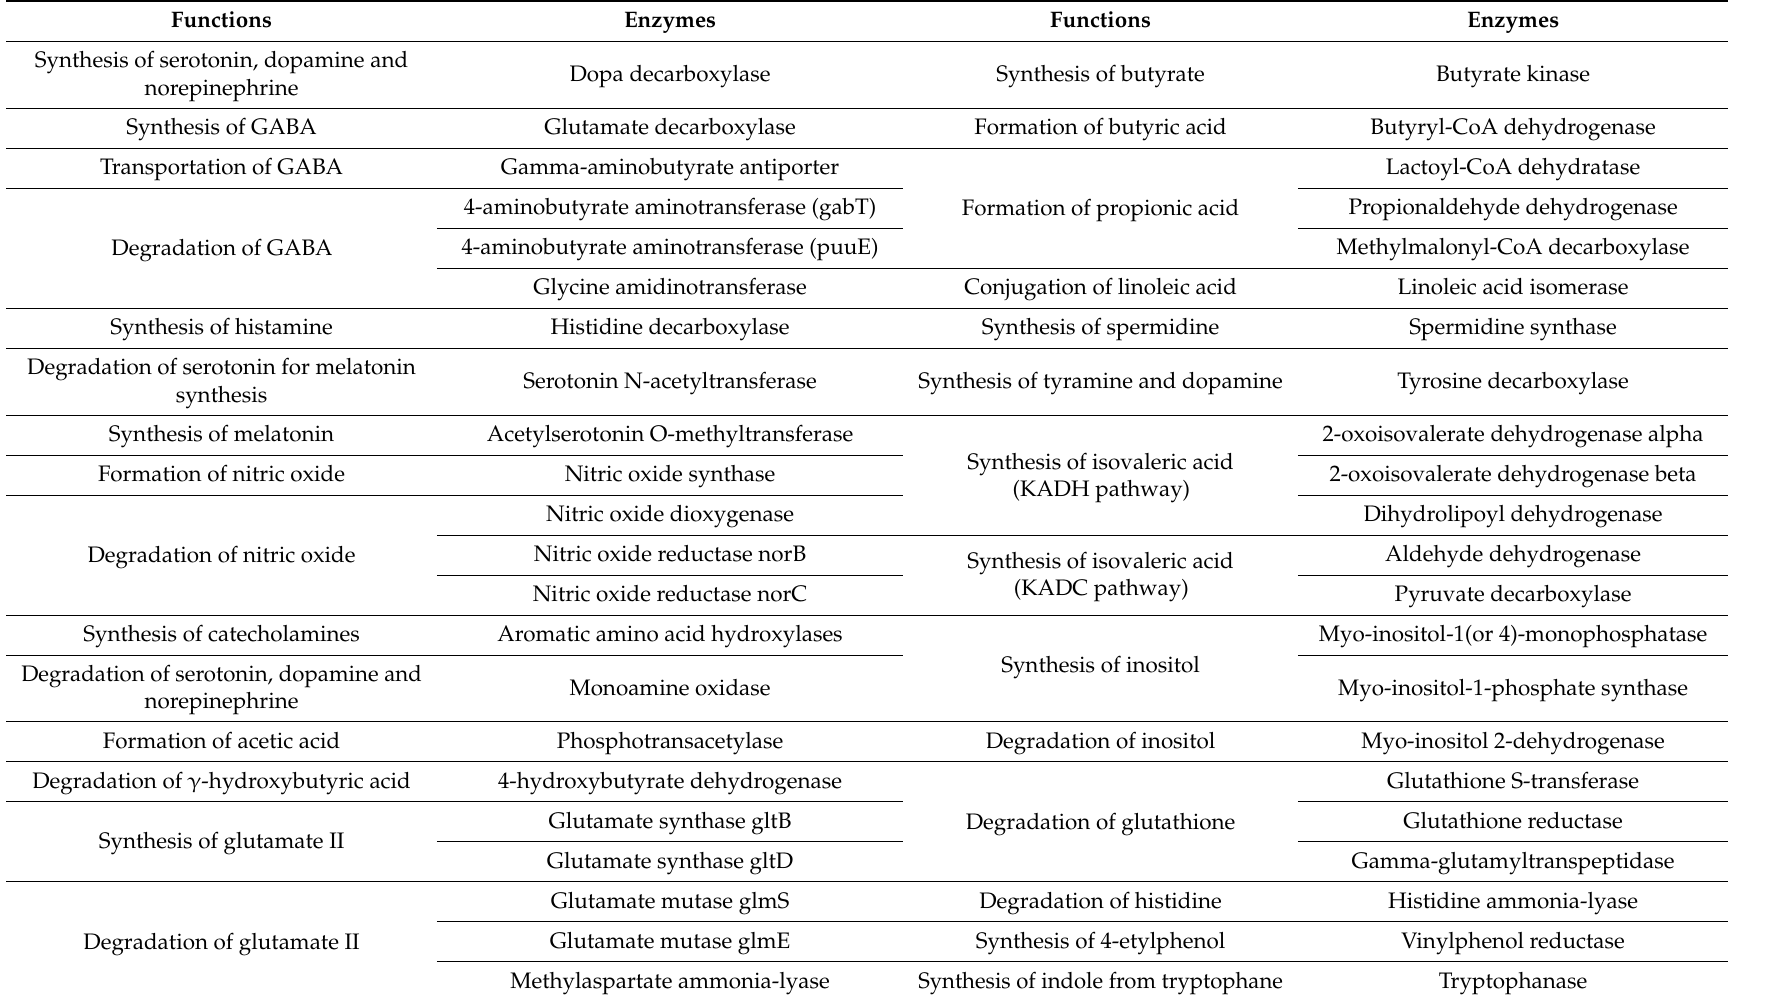
Table 5. Gene catalog of the key bacterial enzymes relevant to